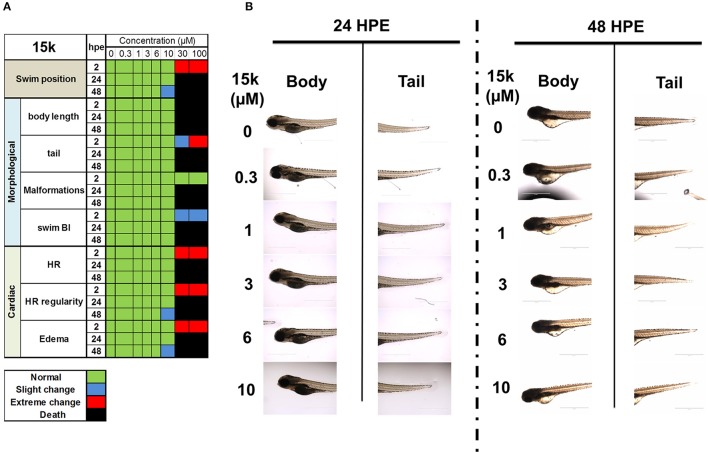
The safety of 15k in zebrafish in vivo model. (A) A heat map table showing the effect of 15k on the swimming position, morphological, and cardiac parameters of the fish at 0, 0.3, 1, 3, 6, 10, 30, and 100 μM for 2, 24, and 48 hpe; (B) The shape of the body and tail of zebrafish after treatment of 15k at 0.3, 1, 3, 6, 10, 30, and 100 μM for 24 and 48 hpe.